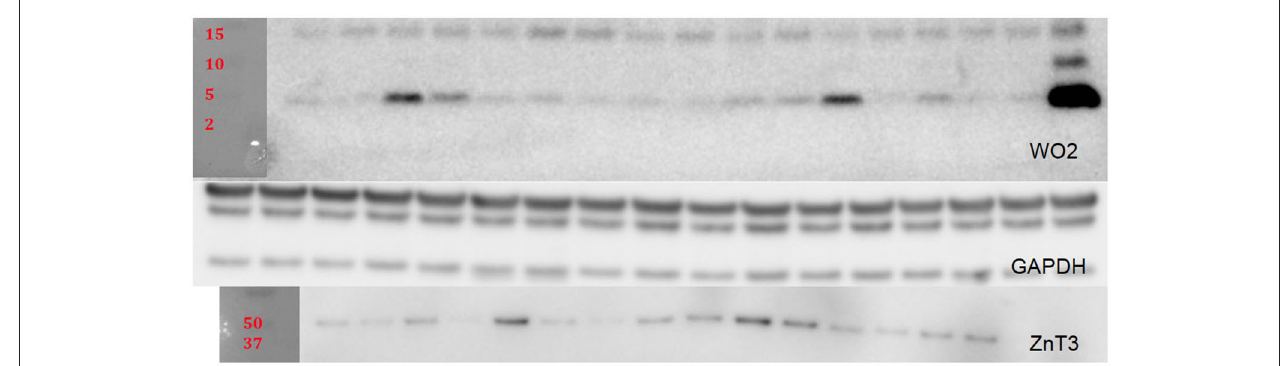
FIGURE 5 | Representative blots are shown for WO2 and ZnT3 which were normalized to